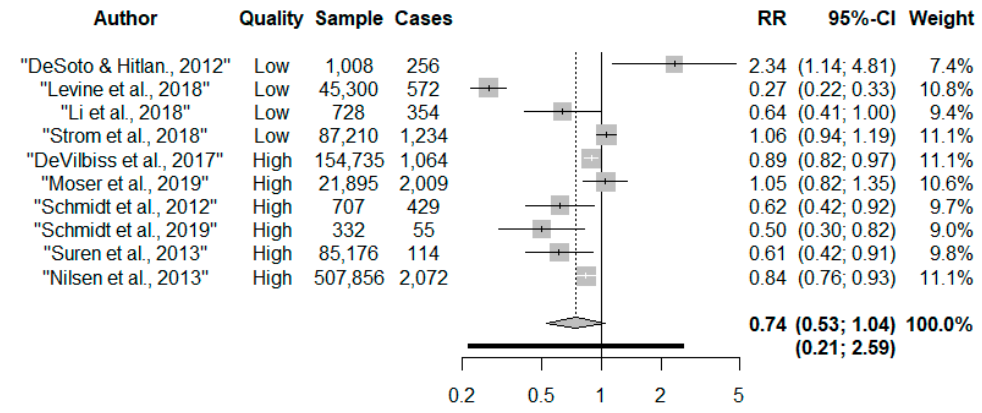
Figure 2. Forest plot of maternal multivitamin supplements and risk of offspring autism [19,21–28,30].